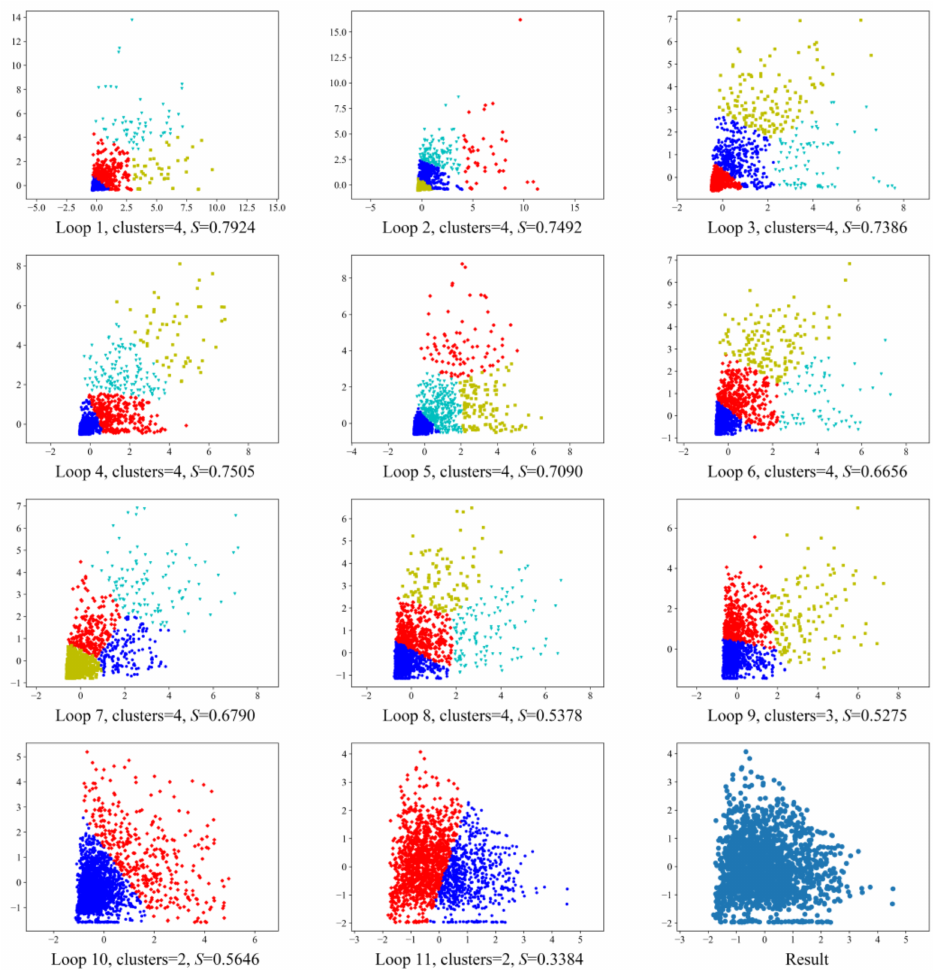
Figure 9. Error clustering on Tr 1